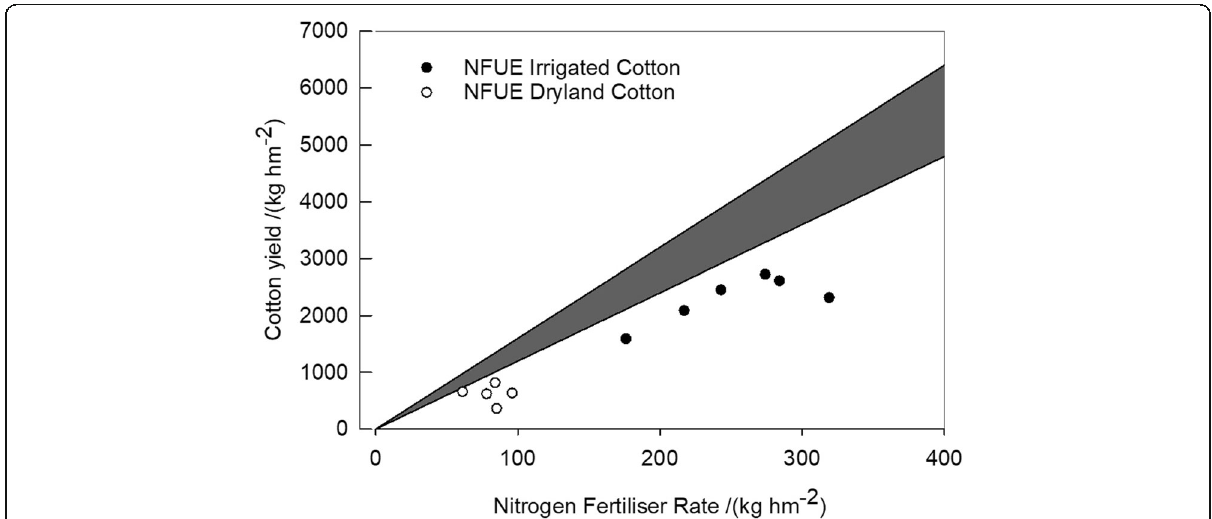
Fig. 2 NFUE in the Australian irrigated and dryland cotton industries. Data correspond to 2001/02, 2010/11 and 2012/13 – 2015/16 seasons. The shaded area represents Rochester ’ s (2014) optimal NFUE